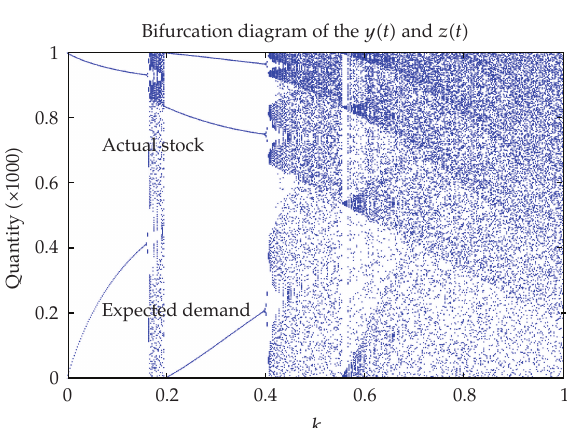
Figure 3: The bifurcation diagram of actual stock and expected